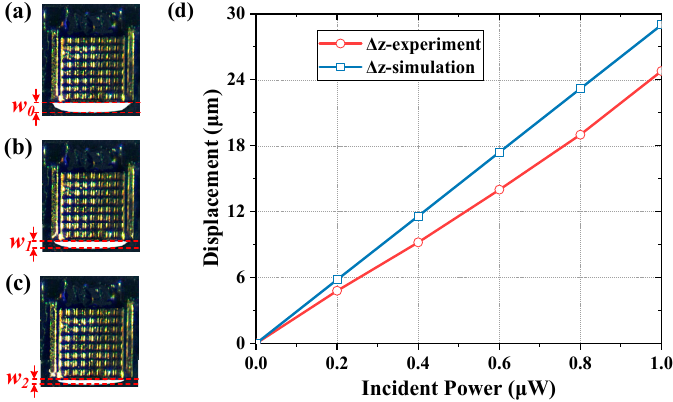
Figure 12. The measured response of the detector. Part ( a – c ) corresponding to incident power of 0 μ W, 0.6 μ W and 1 μ W, respectively, and part ( d ) is the displacement response of simulation (blue line) and experiment (red line).